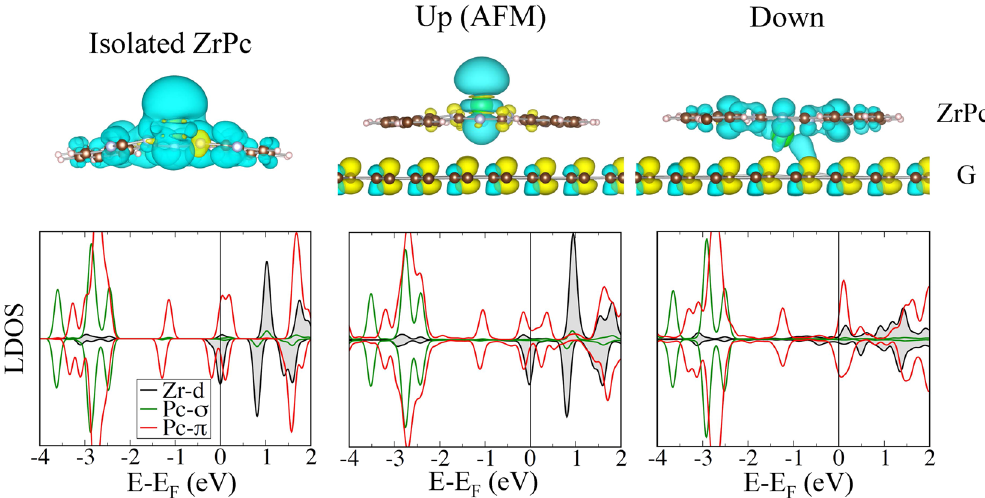
Figure 4. Plots of the spin densities (top panels) and of the spin-resolved LDOS (bottom panels) for an isolated ZrPc molecule (left) and for a ZrPc molecule on G/Ni(111) in the up - (center) and down -configuration (right). For the up -configuration, the plots refer to the (ground state) case of antiparallel alignment of the Zr and Ni magnetic moments (the spin density as well as LDOS of the Ni substrate is not depicted in the plots, for clarity reasons). Cyan (yellow) corresponds to positive (negative) spin density (see text for further